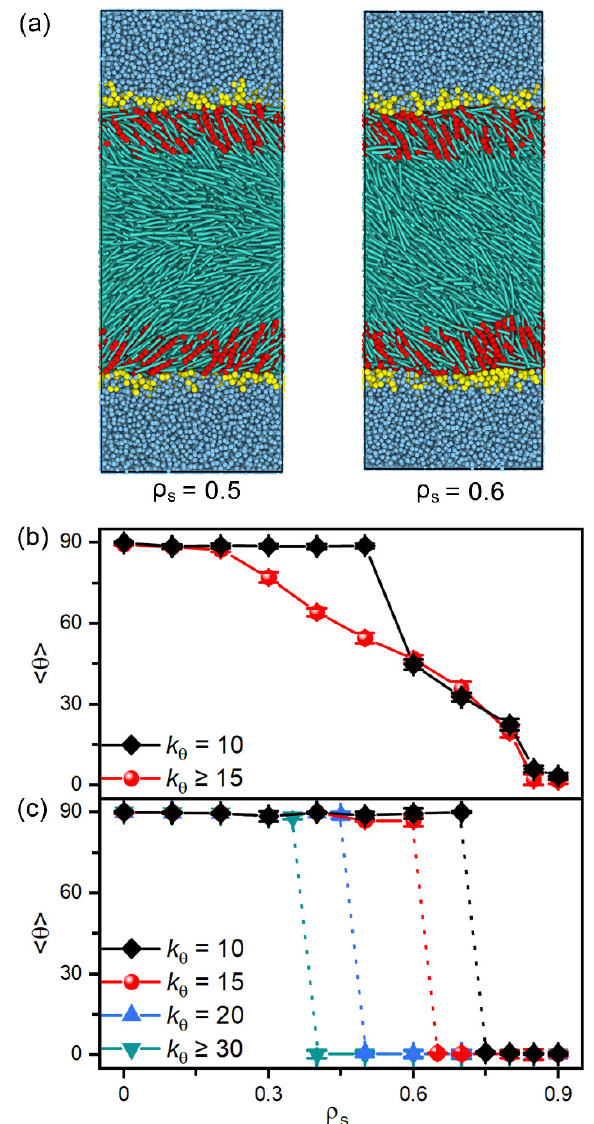
Figure 8. ( a ) Snapshots of the representative planar and tilted anchoring configurations induced by the amphiphiles with softest tails of k θ = 10. The tilt angle of ( b ) nematic and ( c ) smectic LCs as a function of the surface coverage of amphiphiles with tunable tail rigidity of k θ = 10, 15, 20, 30 and 50.